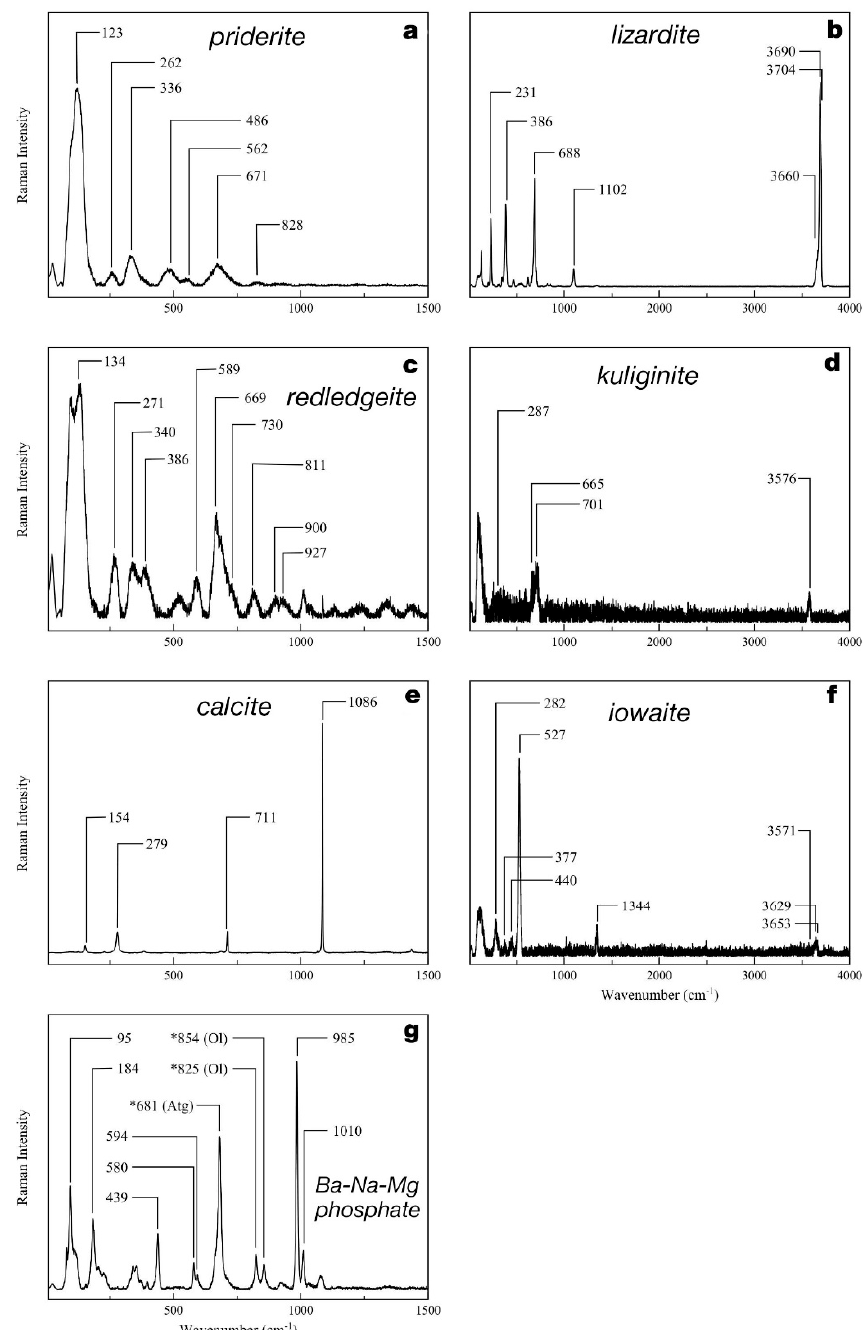
Figure 7. ( a–g ) Raman spectra of the examined minerals. ( g ) shows the Raman spectra of Ba-Na-Mg phosphate with contributions from associated olivine (Ol) and antigorite